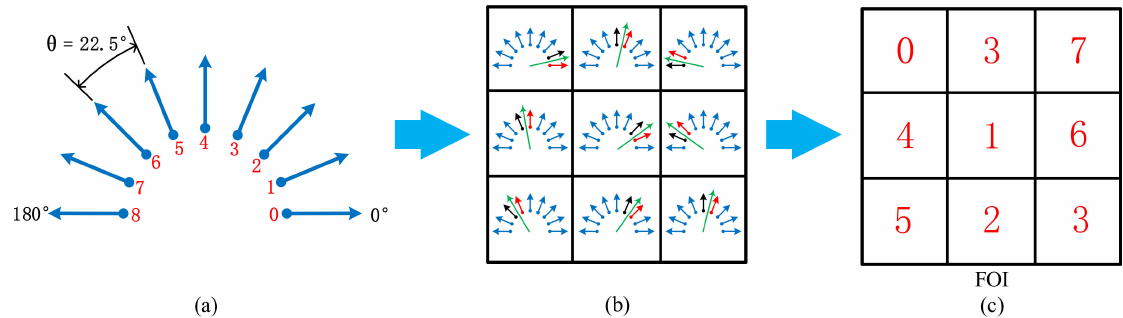
Figure 3. The generation of a feature orientation index table ( FOI ) for an image with nine pixels. ( a ) Nine feature orientations with index numbers 0~8, which are used to divide the range of [ 0 ◦ ,180 ◦ ) into 8 subranges evenly. ( b ) The determination of lower bound (red arrow) and upper bound (black arrow) of a pixel’s gradient direction (green arrow). ( c ) FOI